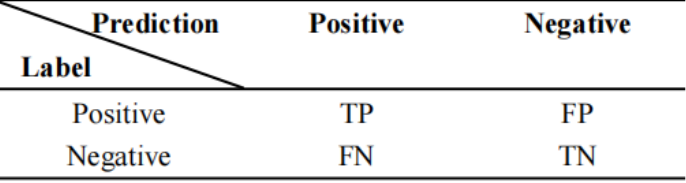
Figure 8. Matrix of classification